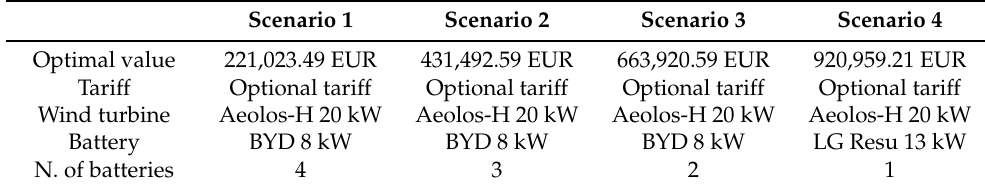
Table 5. Optimal solutions for each scenario.